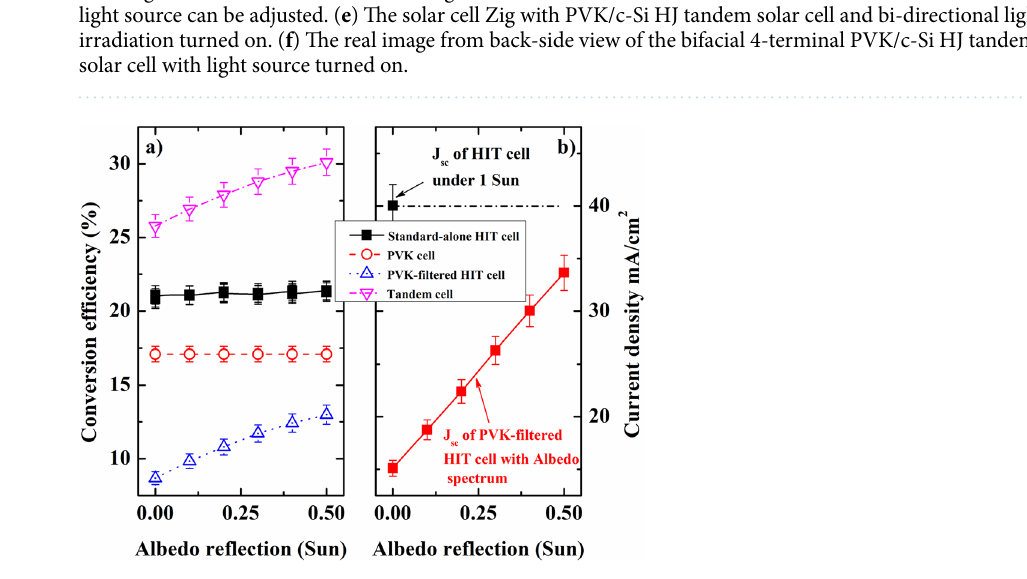
Figure 6. ( a ) The conversion efficiency of the PVK top sub-cell (red color), standard-alone c-Si HJ solar cell (black color), PVK-filtered c-Si HJ solar cell (blue color), and a bifacial 4-terminal PVK/c-Si HJ tandem solar cell (pink color) as a function of albedo reflection. ( b ) J sc of the standard-alone c-Si HJ solar cell under 1 sun (black color) and the J sc of the PVK-filtered c-Si HJ solar cell bottom sub-cell as a function of the albedo spectrum (red